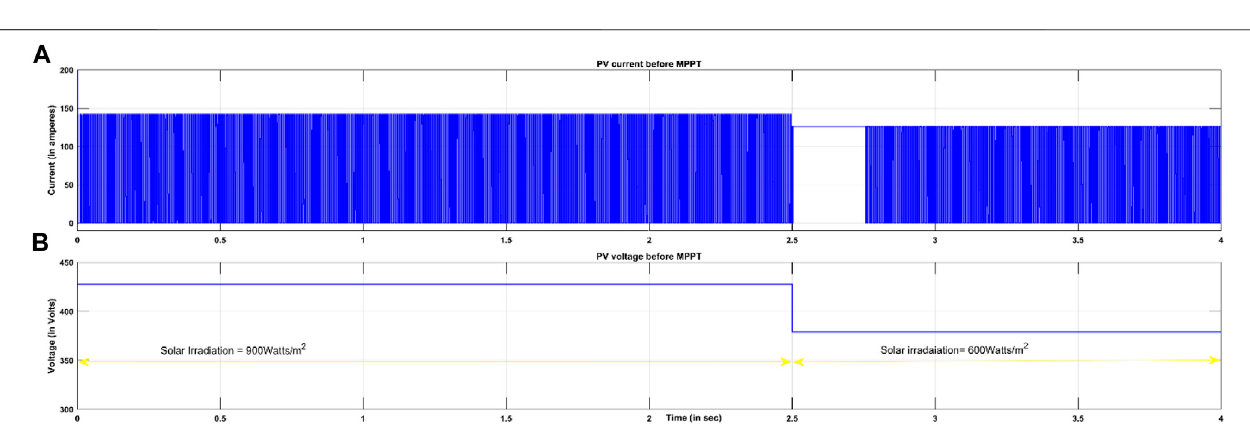
FIGURE 4 | PV current and voltage before